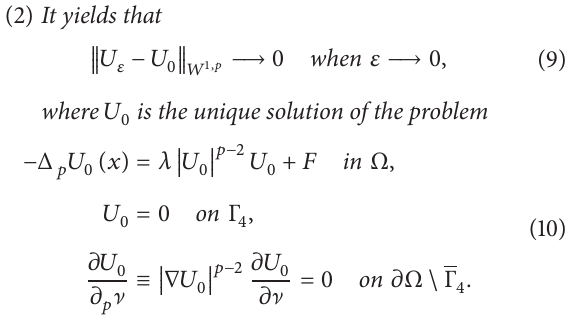
Figure 2: Parts of Ω 𝜀